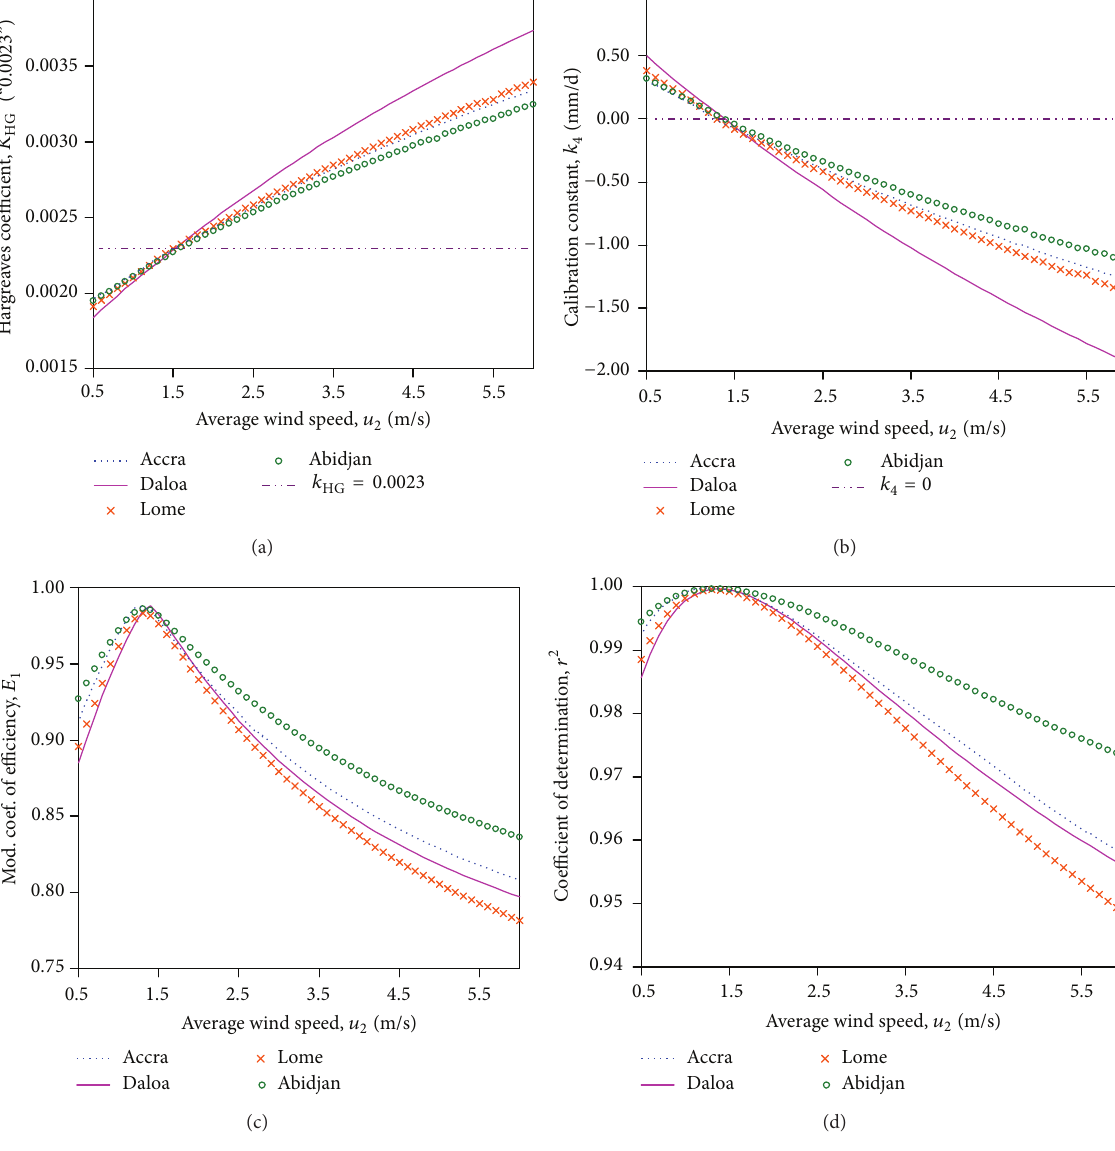
and 𝑘 4 for LHG and corresponding 𝐸 1 and 𝑟 2 for 𝑢 2 in the range 0.5–6.0 m/s for Abidjan, Accra, HG